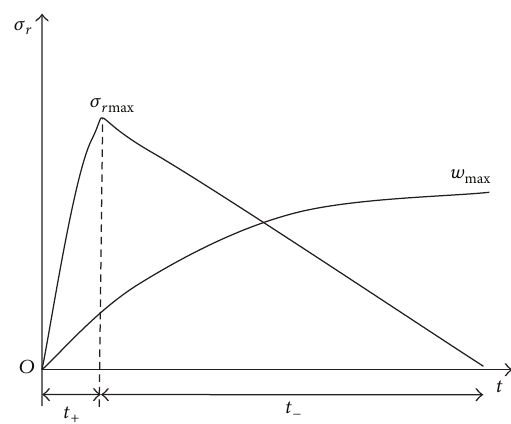
Figure 2: The stress wave and deformation of material near penetration cavity [11, 18,